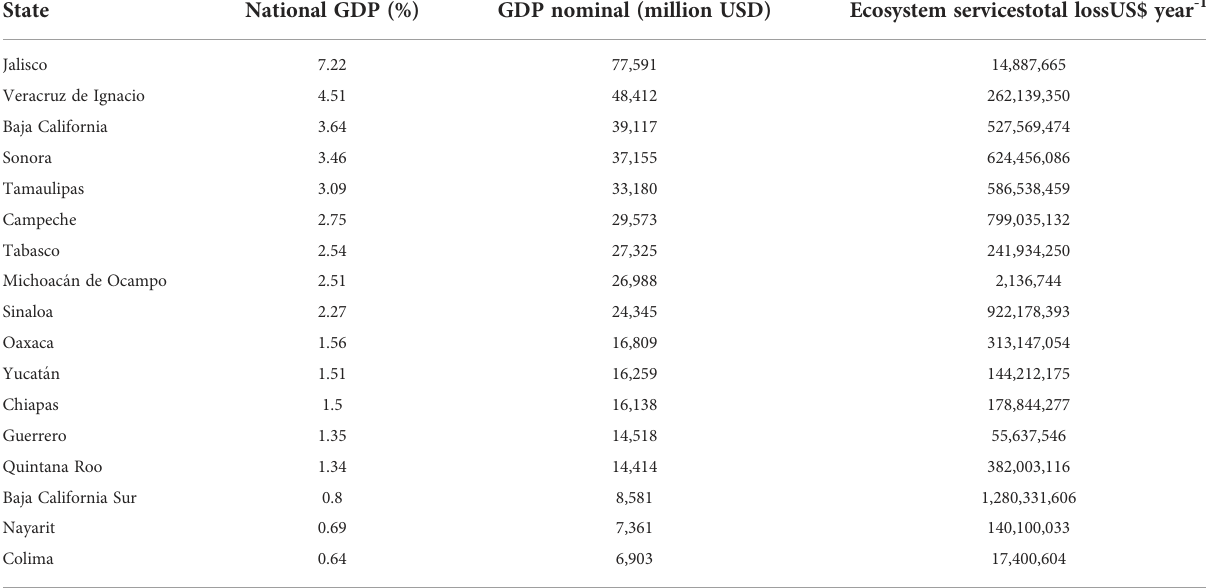
TABLE 5 Comparison between the GDP of Mexico ’ s coastal states in 2020 (in millions of GDP) and the monetary cost for the loss of ecosystem services.